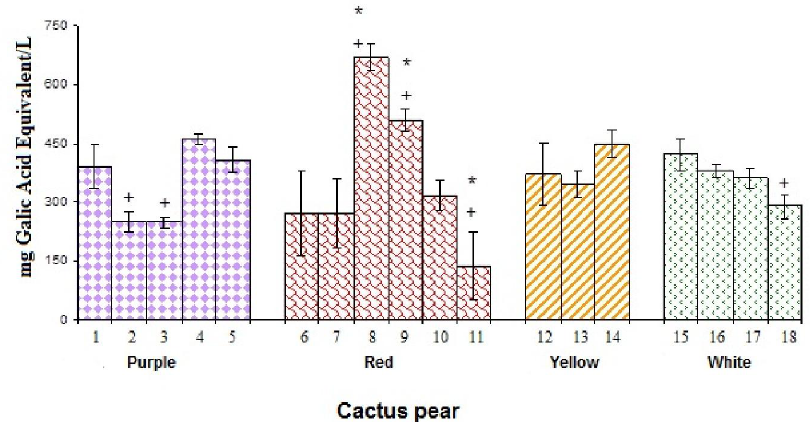
Figure 4. Total phenolic contents of cactus pear cultivars. * denotes statistical significance at p < 0.05 among all studied cultivars of cactus pears. + indicates statistical significance at p < 0.05 among the cultivars of cactus pears in the same